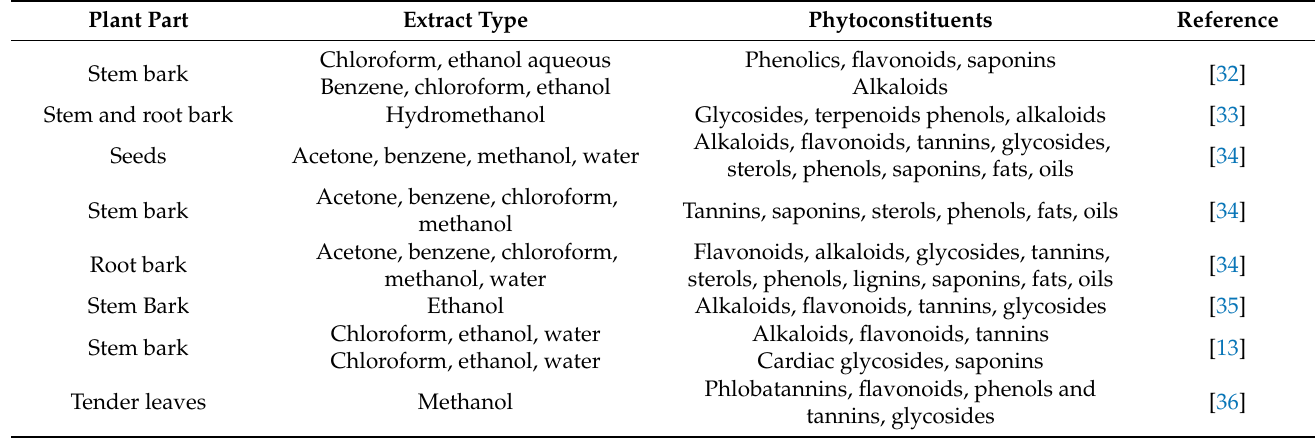
Table 2. Different phytoconstituents detected in the Oroxylum indicum.